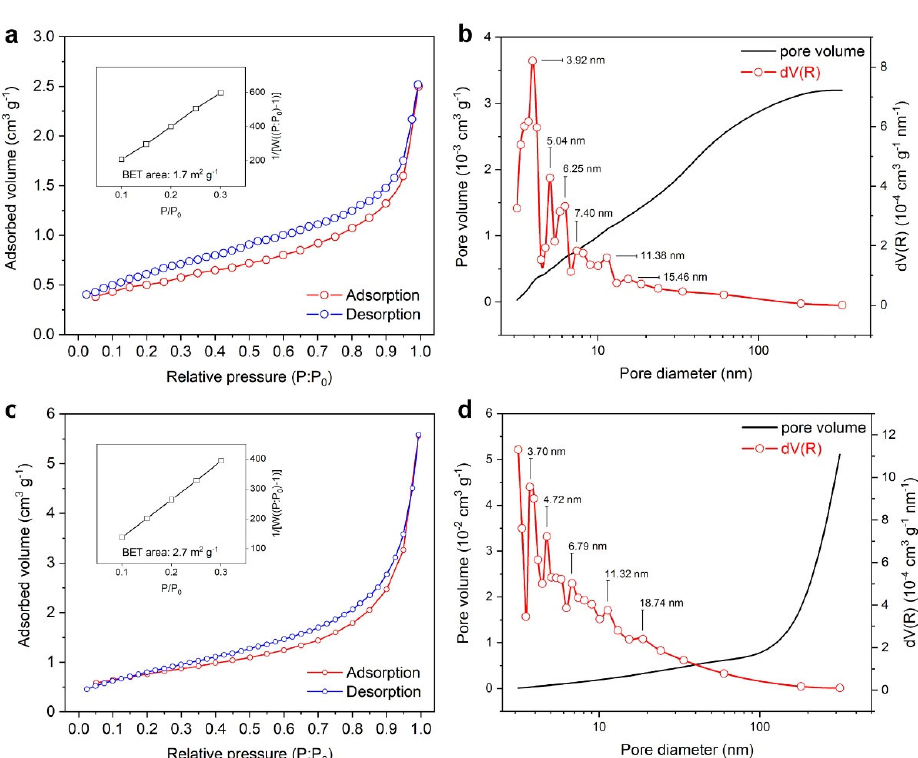
Figure 2. ( a ) BET adsorption/desorption isotherms, with inlet showing BET surface area calculation; and ( b ) BJH microporosity for untreated powders. ( c ) BET adsorption/desorption isotherms, with inlet showing BET surface area calculation; and ( d ) BJH microporosity for sintered powders. Surface area modestly increased after thermal treatment; porosity was conserved at the mesoporous regime.